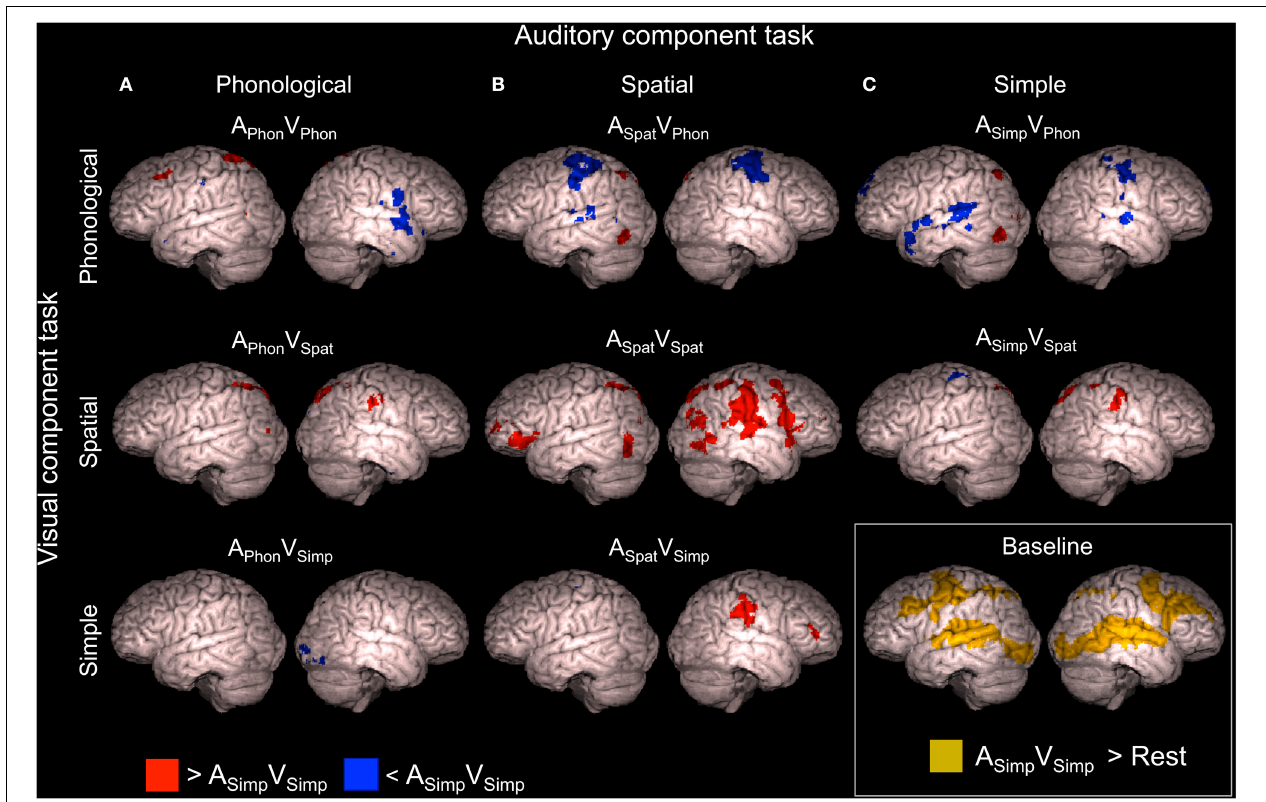
FIGURE 3 | Brain activity during dual tasks in relation to the baseline dual task. Areas showing significant ( Z > 2 . 3, cluster corrected P < 0 . 05) activity in relation to the A Simp V Simp dual task (simultaneous speaker-gender and font-shade discrimination task) used as the baseline. Dual tasks including the (A) auditory phonological, (B) auditory spatial, and (C) auditory simple component tasks compared with the baseline dual task. Dual tasks including